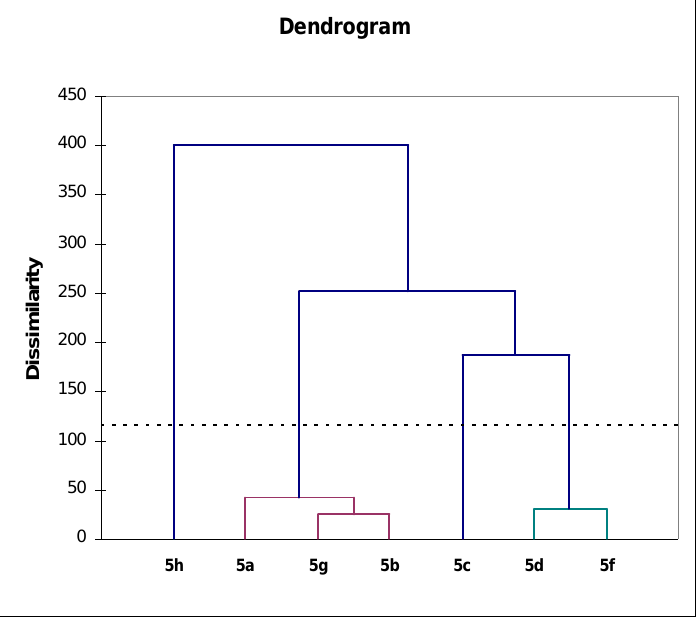
Figure 1. Dendrogram (AHC analysis) representing antimicrobial activity (variables- diameters of growth inhibition zones) dissimilarity relationships of the synthesized compounds (observations) obtained by Euclidian distance dissimilarity (dissimilarity within the interval [ 0, 400 ] ), using aggregation criterion-Ward’s method. Four groups of the compounds were